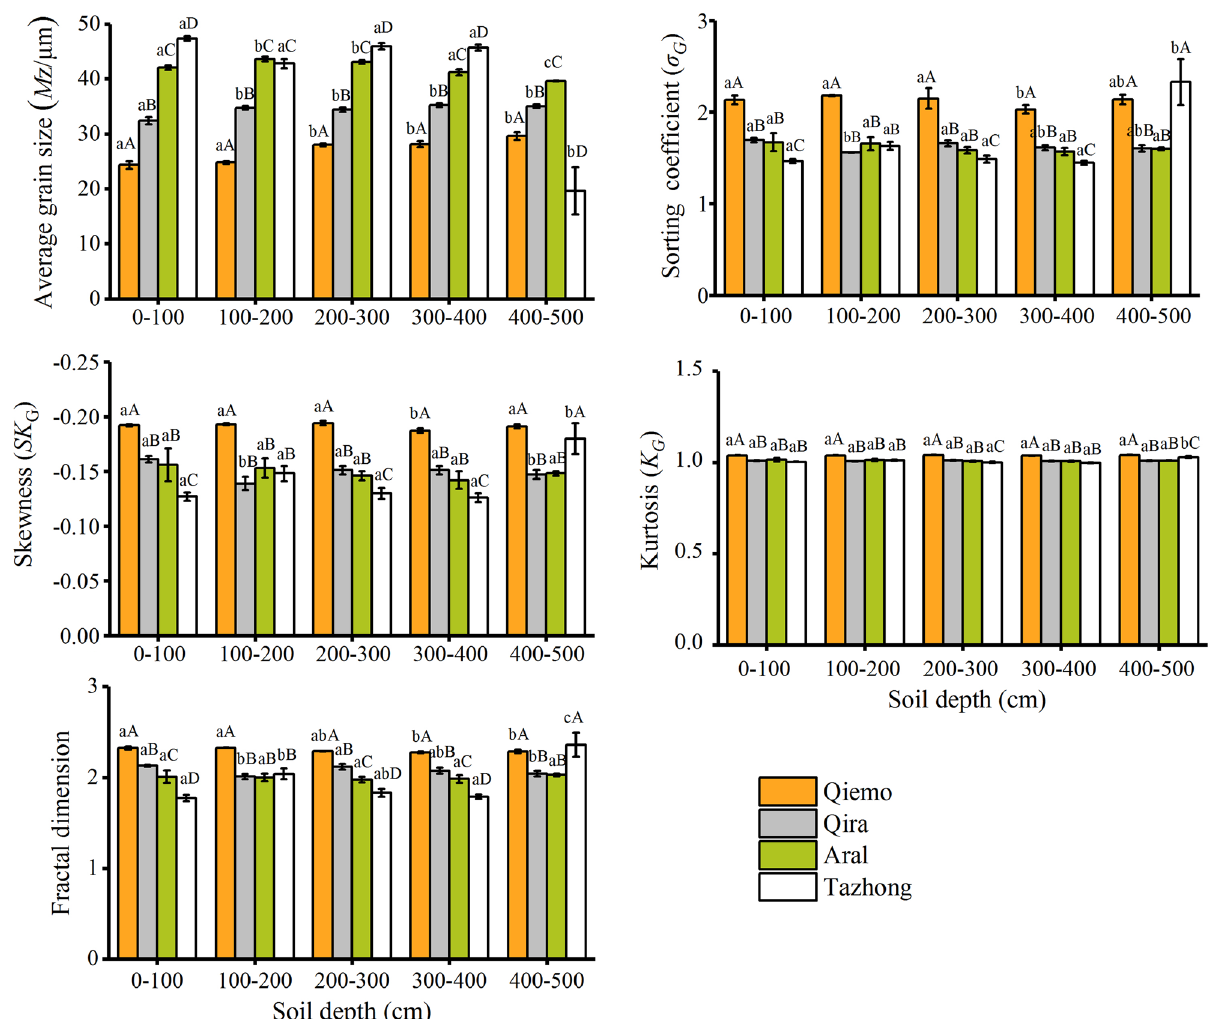
Figure 3. Grain-size parameters of soil at the different